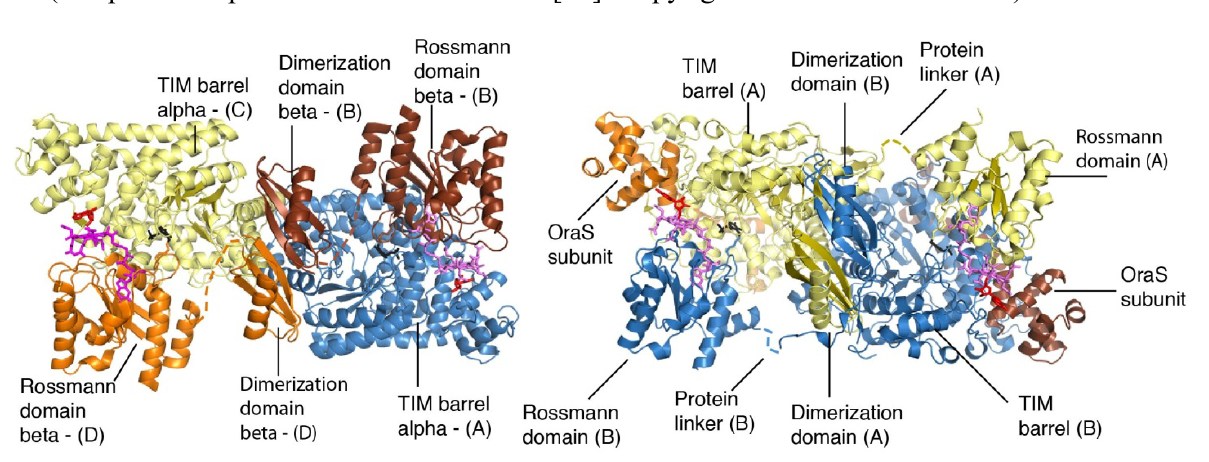
Figure 1. Crystal structures of ( left ) 5,6-LAM and ( right ) 4,5-OAM in open state (Adapted with permission from reference [25]. Copyright 2012 Annual